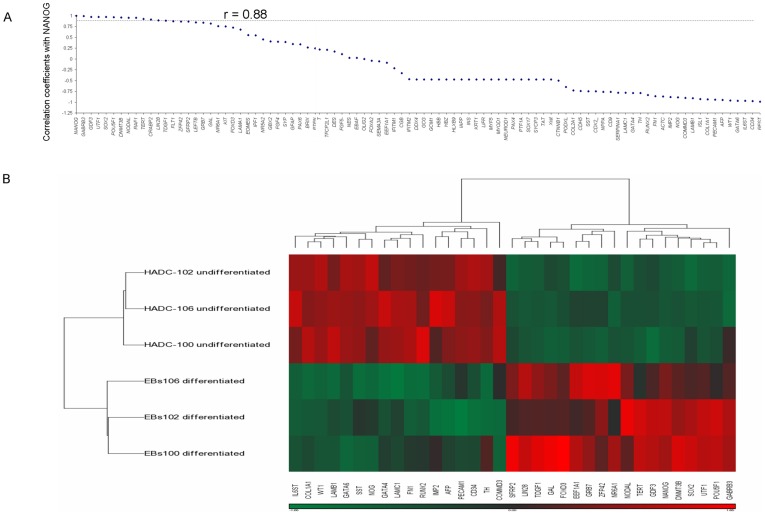
Gene expression analysis of undifferentiated and differentiated progeny of the three hESC lines.Pairwise correlation of NANOG expression with that of all tested genes of the panel of HADC-100, HADC-102 and HADC-106 hESCs is presented in (A). Gene expression is presented by the DeltaCt value of each gene, normalized against the average Ct of three endogenous control genes (Table S9). The Pearson correlation coefficient was calculated from the combined data of DeltaCt values of undifferentiated and differentiated hESCs of the three lines. The results were plotted in descending order of the correlation coefficient values. Clustering analysis of genes that were differentially expressed in the three lines in the undifferentiated and differentiated state is presented in (B). An unpaired t-test for differential gene expression between undifferentiated and differentiated samples yielded 35 genes with a P- value <0.05. Two-way hierarchical clustering with Euclidean distance was performed on the 35 genes and six samples. Green colors in the heat map represent low DeltaCt or high expression. Red colors represent high DeltaCt or low expression.